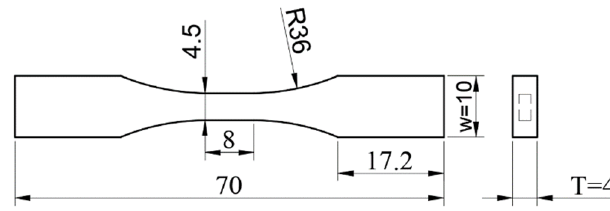
Figure 1. The dimension of fatigue samples (unit, mm).